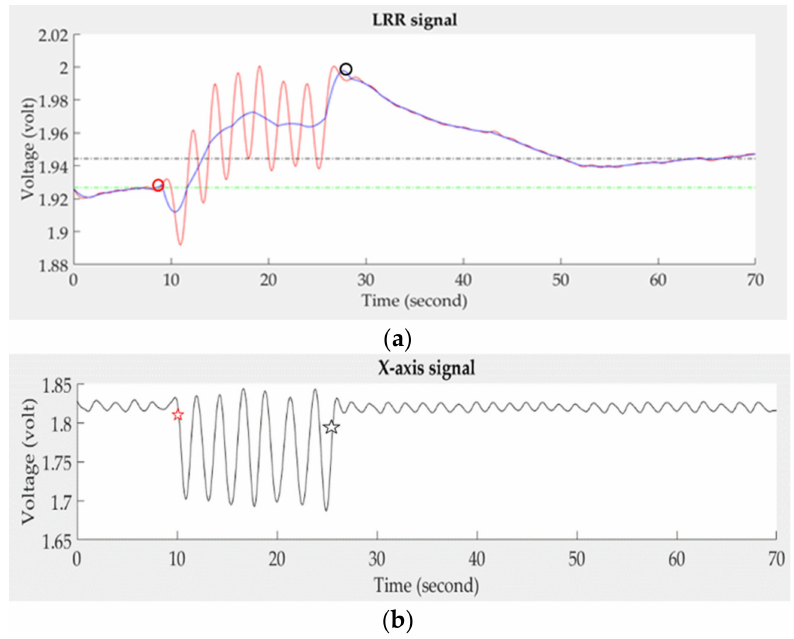
Figure 5. ( a ) Four characteristics of the smooth LRR signal (blue line), LRR start (red circle symbol), LRR end (black circle symbol), resting baseline (short green dash line), and refilling baseline (long blue dash line), ( b ) two characteristics of the accelerometer signal, X start and X end (red and black star